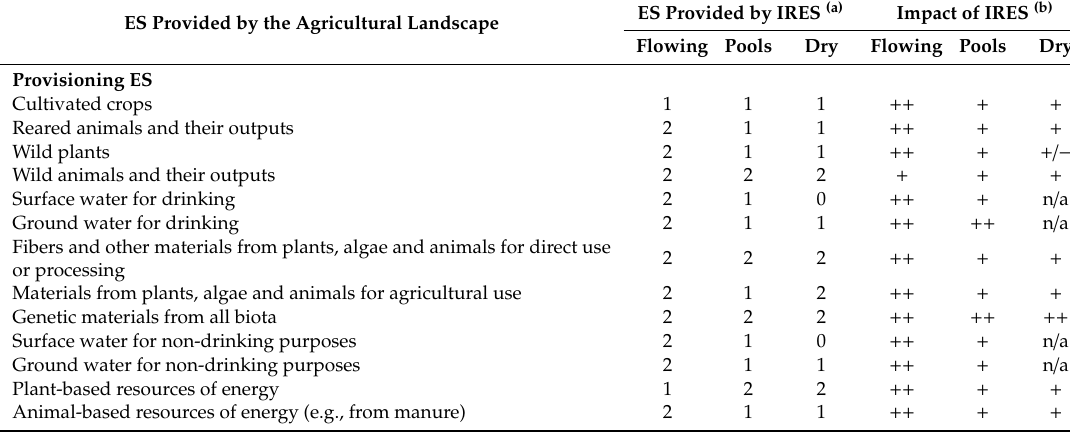
Table 2. List of ecosystem services provided by the agricultural landscape; the relation of the hydrological phase of IRES to provide each ES and the impact of the hydrological phase of IRES in the ES by the agricultural